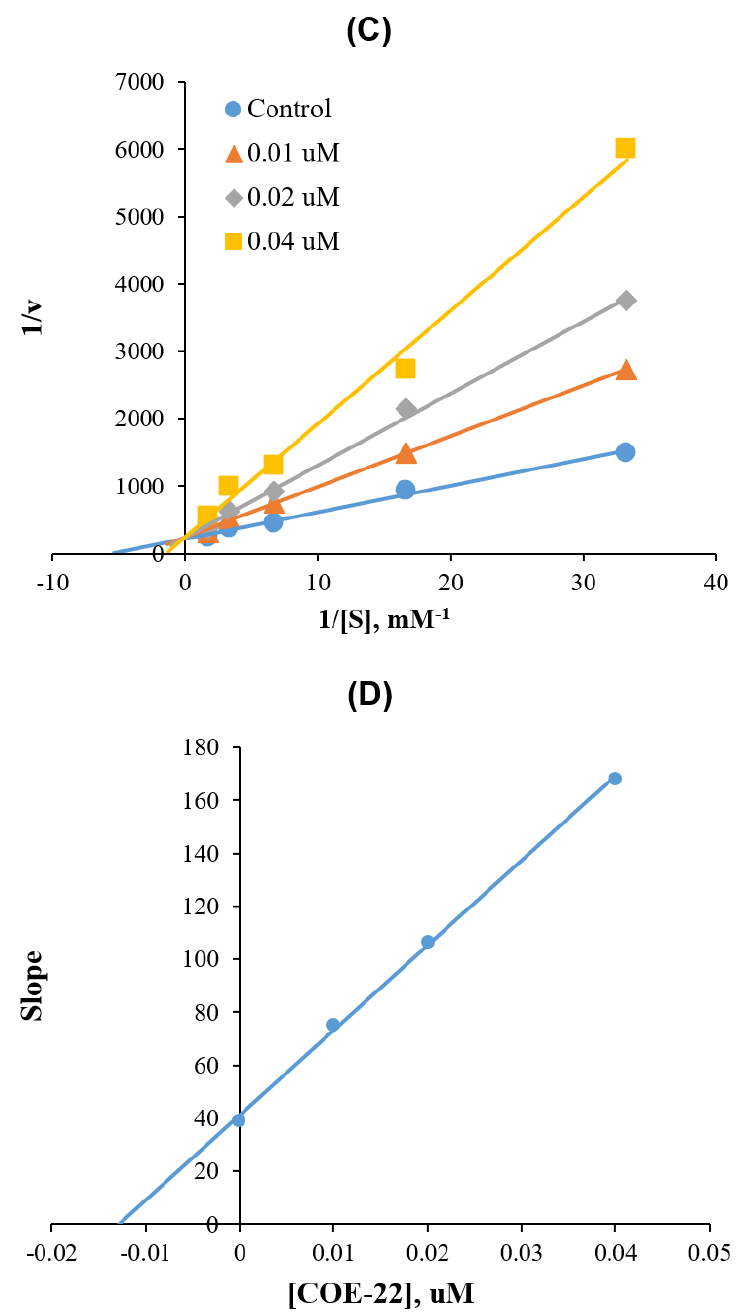
Figure 3. Lineweaver–Burk plots for MAO-B inhibition by COE-6 ( A ) and COE-22 ( C ), and their respective secondary plots ( B , D ) of slopes vs. inhibitor concentrations. Table 2. Docking scores and ∆ G binding values of lead compounds with MAO-A and MAO-B. Docking Score (kcal / mol) ∆ G binding (kcal / mol) Compound MAO-A